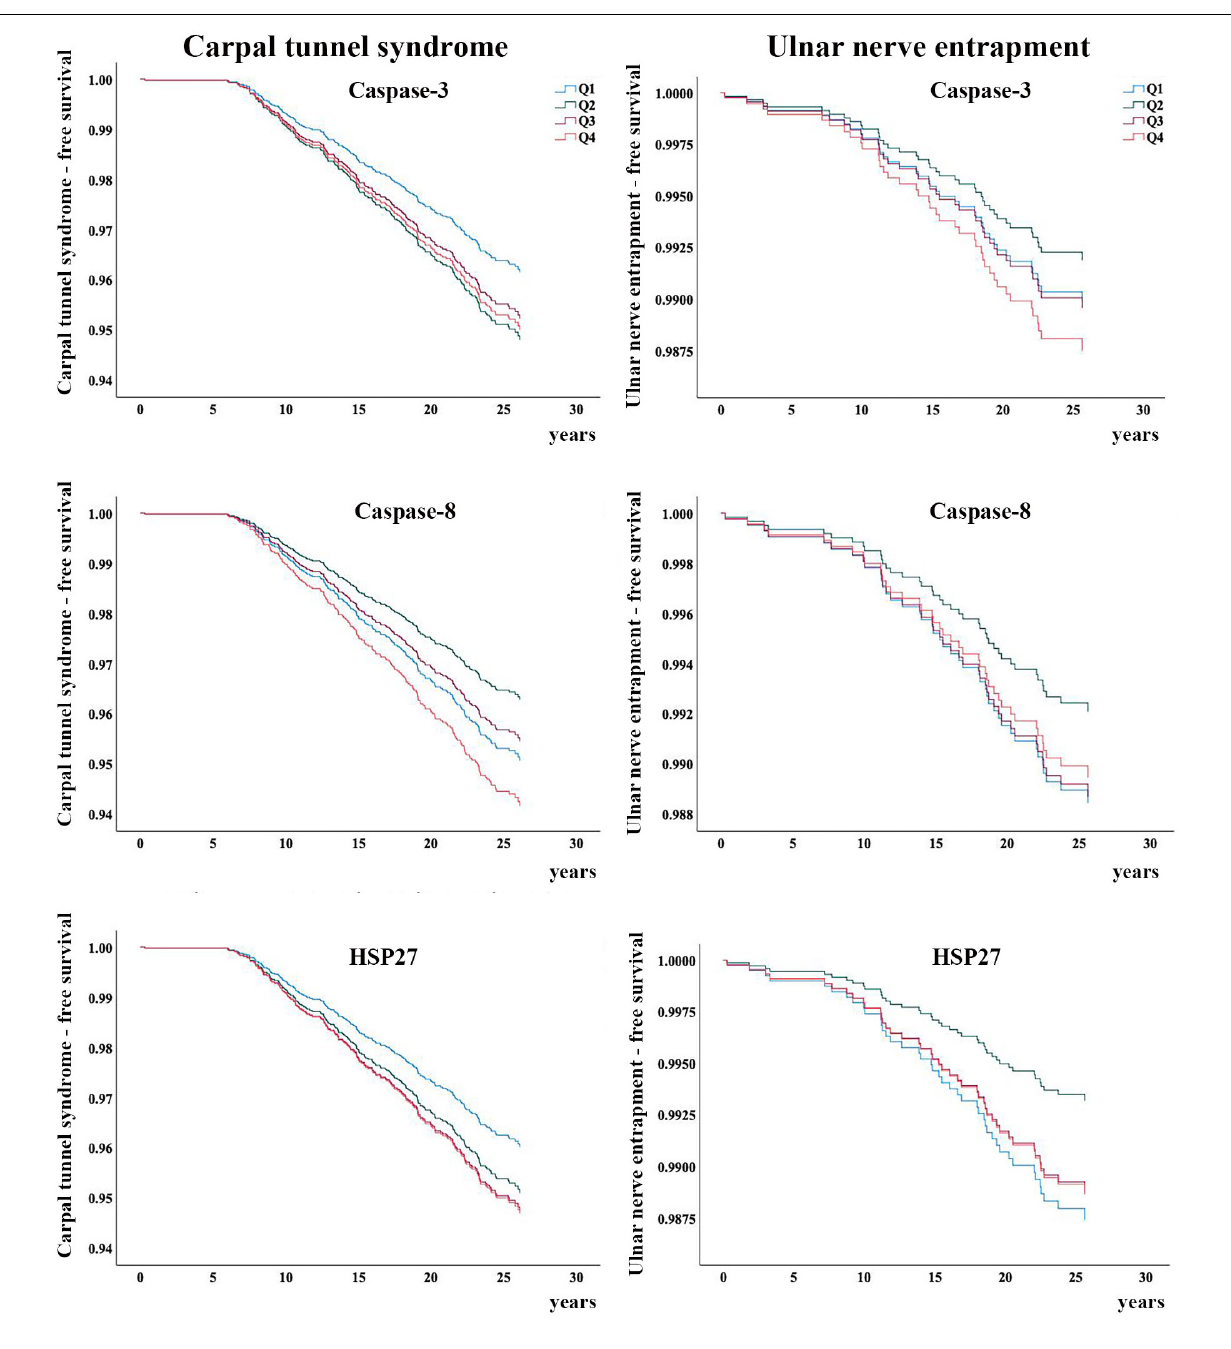
FIGURE 2 | Carpal tunnel syndrome-free and ulnar nerve entrapment-free survival in relation to the quartiles of caspase-3, caspase-8 and HSP27, respectively. Q,